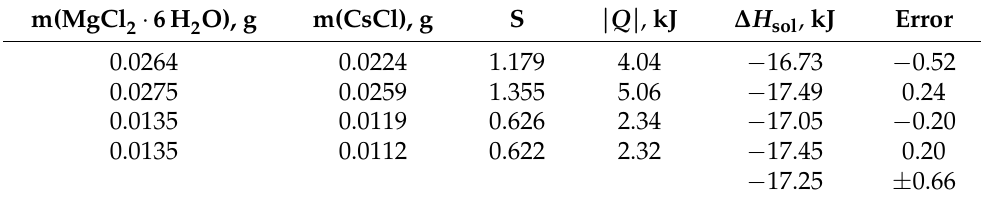
· 6H O + CsCl ) measurements. 2 2